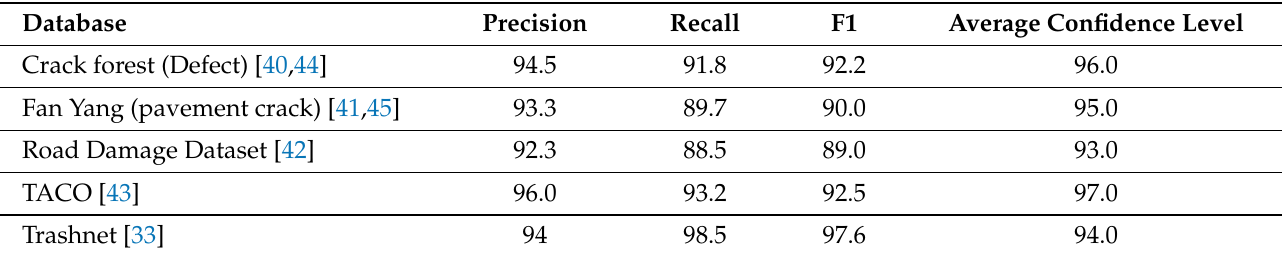
Table 6. Case study for the Convolution Neural Network for road